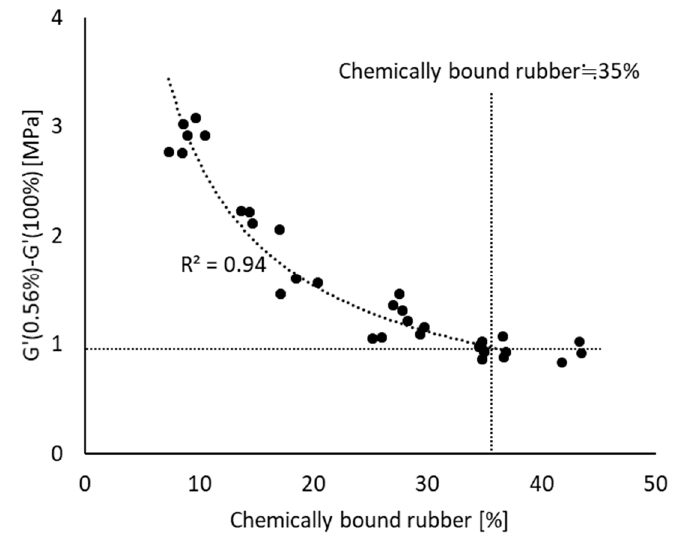
Figure 5. Payne effect vs. chemically bound rubber content; fitting line is based on polynomial fit with maximum R 2 .